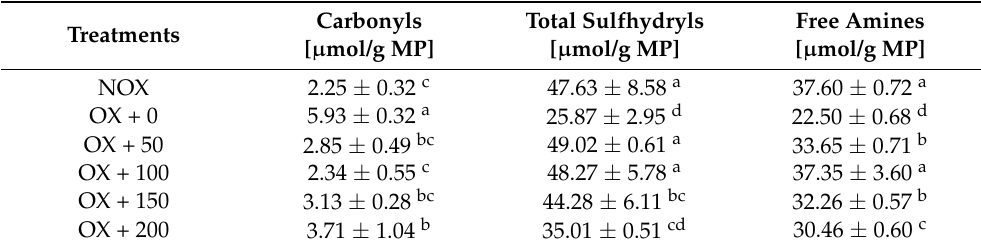
Table 1. Changes in amino acid side chains in MPs treated with various addition of FOs (0, 50, 100, 150, and 200 µ mol/g protein) under nonoxidizing (NOX) or oxidizing (OX) conditions. Values are means ± the standard deviations (SDs). Different lowercase letters indicate significant differences ( p < 0.05). NOX refers to nonoxidized MPs; OX + 0 refers to oxidized MPs; OX + 50/100/150/200 refers to 50/100/150/200 µ mol/g protein FOs added to oxidized MPs, similarly for other tables